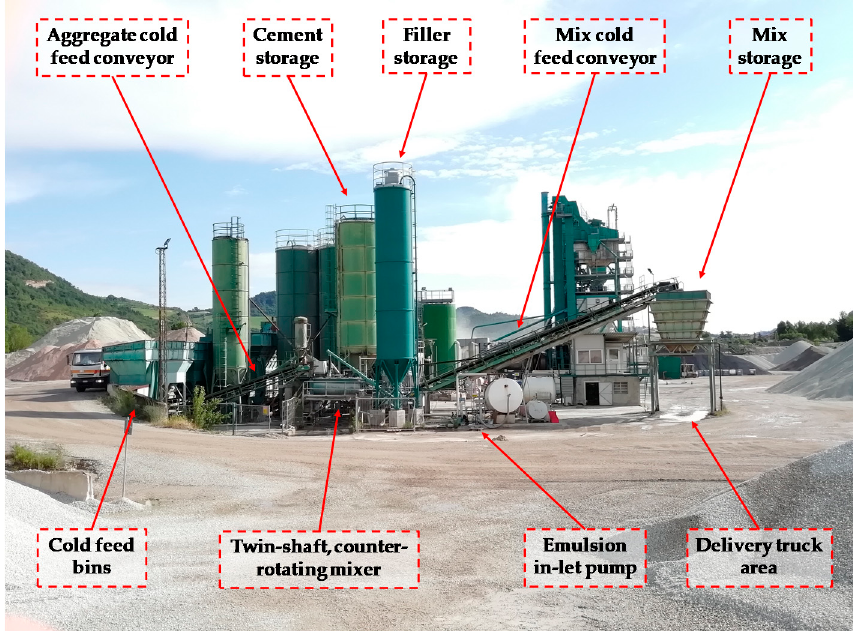
Figure 2. Mixing plant for cold mixture production.